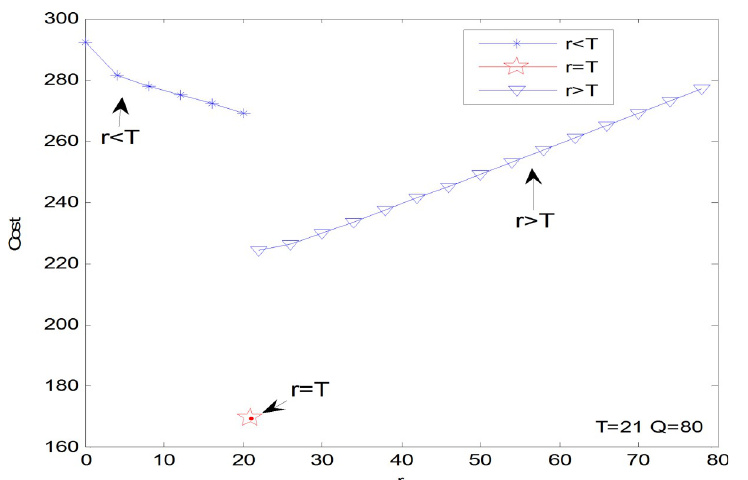
Fig 4. The inventory cost as a function of r